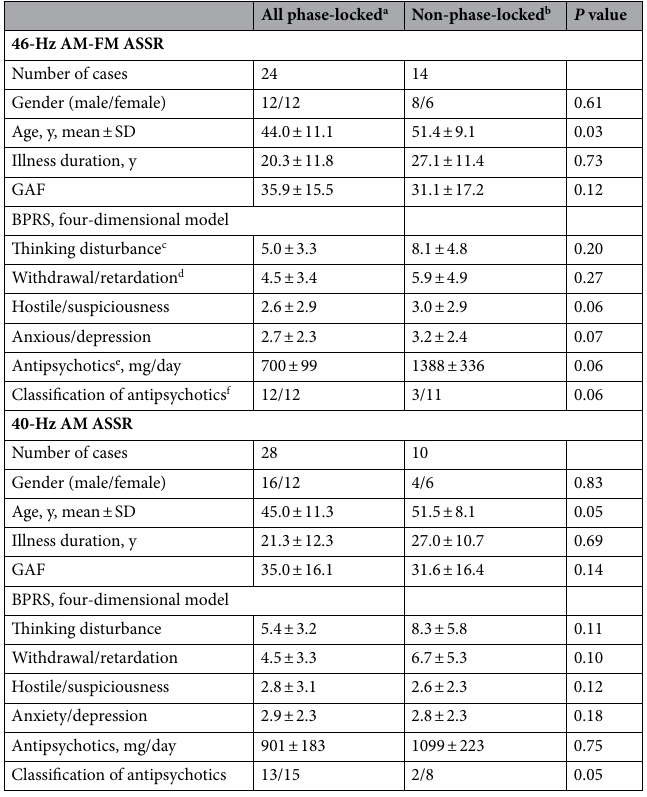
only in 46-Hz AM-FM ASSR. The difference between the two ASSRs in terms of the number of patients with non-phase-locked responses was not significant ( P = 0.46, Fisher’s exact test). Clinical variables in patients with and without non-phase-locked responses. We defined the all phase-locked group as those who manifested phase-locked responses in all three ASSR measurements and the non-phase-locked group as the patients who manifested at least one non-phase-locked response in the three ASSR measurements. In the logistic regression analysis, significant differences were found between the two groups for both ASSRs in terms of age and in terms of classification of antipsychotics for the 40-Hz AM ASSR (Table 2). No other significant differences were found in terms of other clinical variables between the two groups in either the 46-Hz AM-FM ASSR or the 40-Hz AM ASSR. Number of trials to achieve phase-locked response. To further investigate the details of ASSR, addi- tional parameters were examined. Significant increases were noted in the number of trials required to achieve a phase-locked response in patients with schizophrenia (46-Hz AM-FM ASSR, mean ± SD = 35.5 ± 17.4; 40-Hz AM ASSR, 31.0 ± 15.9) as compared with healthy subjects (46-Hz AM-FM ASSR, 20.2 ± 3.8; 40-Hz AM ASSR, 20.3 ± 3.3) in either of the ASSRs (46-Hz AM-FM ASSR, t = 5.3, df = 74, P < 0.0001; 40-Hz AM ASSR, t = 4.0, df = 74, P = 0.0001) (Fig. 2a). Response amplitude. The response amplitude of the 40-Hz ASSR did not significantly differ between patients with schizophrenia (46-Hz AM-FM ASSR, 0.35 ± 0.26 µV; 40-Hz AM ASSR, 0.35 ± 0.16 µV) and healthy subjects (46-Hz AM-FM ASSR, 0.38 ± 0.12 µV; 40-Hz AM ASSR, 0.36 ± 0.11 µV) in either of the ASSRs (46-Hz